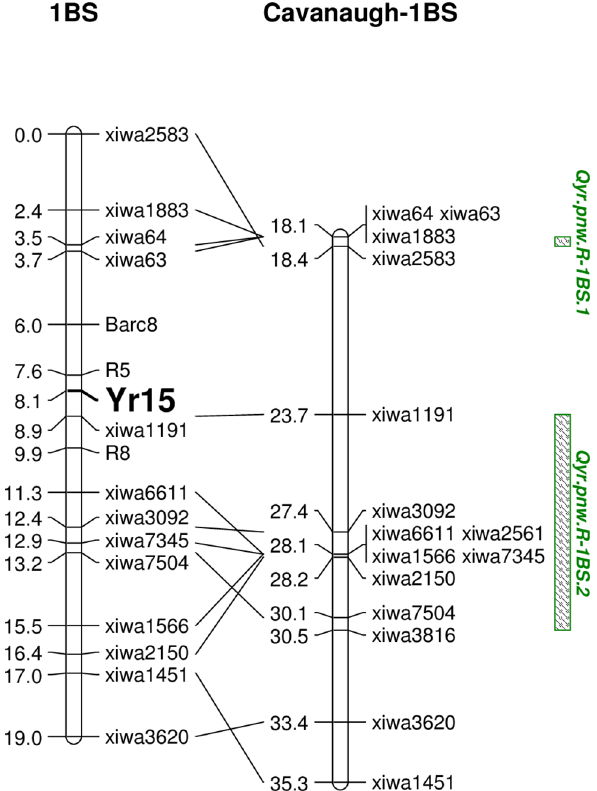
Fig 4. Partial genetic linkage map of chromosome 1BS from WA8149/S0900001L recombinant inbred line population showing Yr15 location and comparisons with the consensus map of Cavanagh et al. (2013). The lines connect markers in common between the two maps. Green-shaded boxes denote two stripe rust resistance QTL identified from the panel in this study.